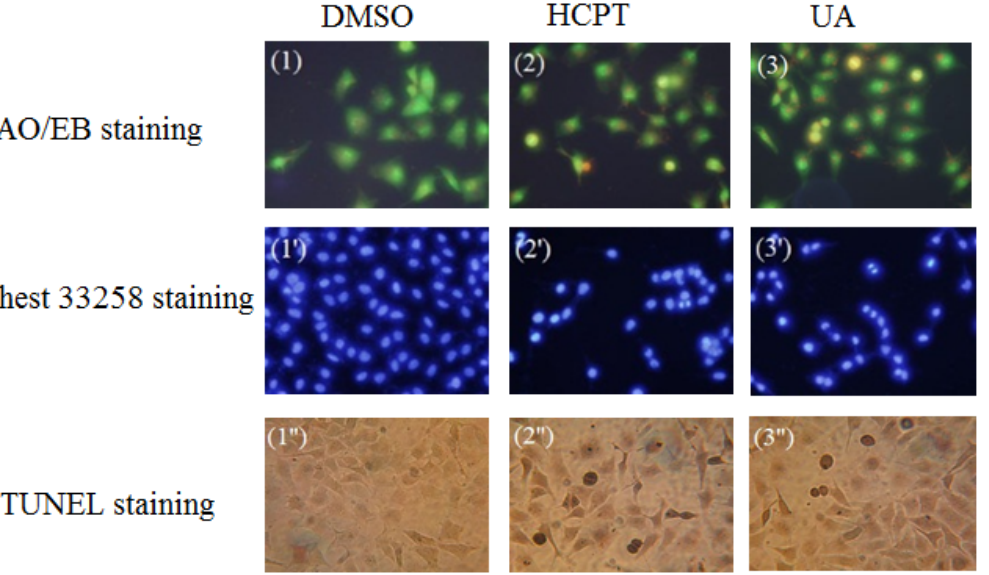
Figure 2. Investigation on the changes in the morphological characteristics of MGC-803 cells during UA-induced